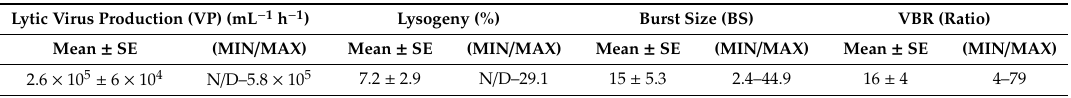
Table 1. Average ( ± SE) with the minimum and the maximum values of lytic virus production (LVP) obtained from viral reduction, estimation of lysogenic bacterial percentages based on induction by mitomycin C, burst size (BS) for monthly individual incubation experiments since December 2017 to October 2018, and virus-to-bacterium ratio (VBR) from viral and heterotrophic bacterial abundances during the time series sampling from October 2017 to October